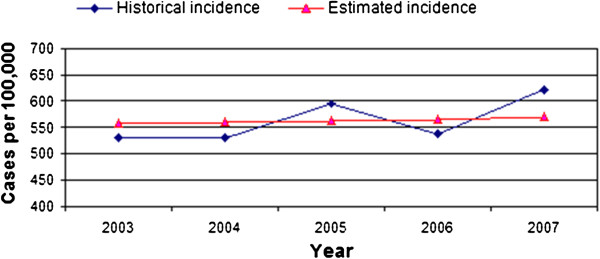
Annual rate of pneumococcal infections [[21]-[26]].